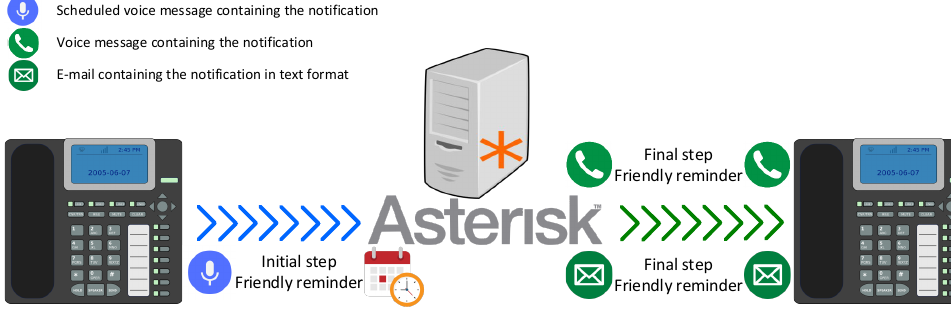
Figure 5. Architecture of the project to develop a notification management